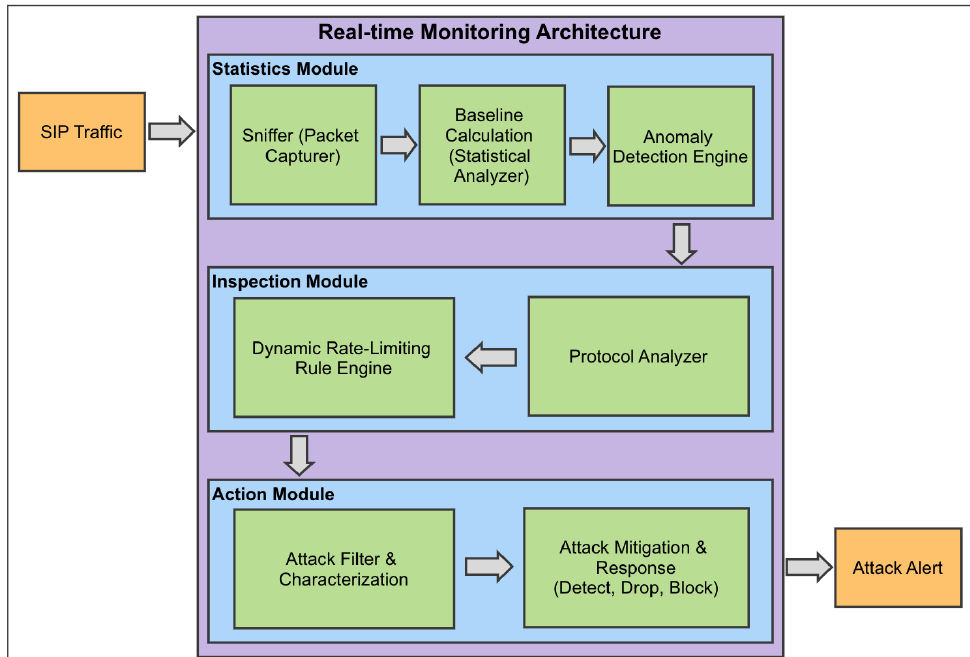
Figure 5. Proposed defense mechanism application